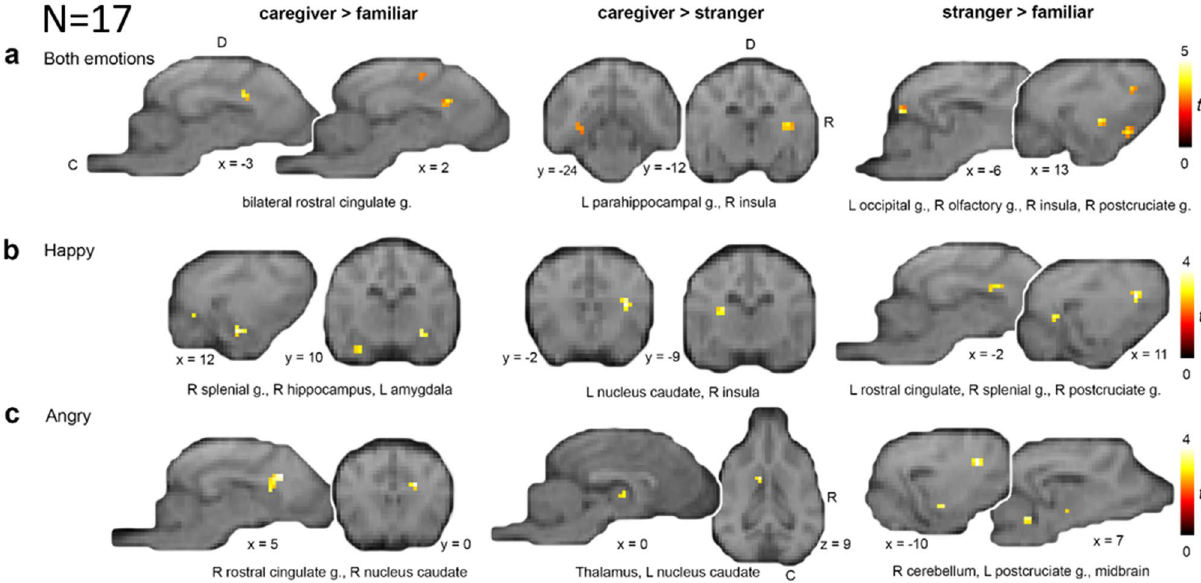
Figure 1. Visual presentation of caregiver (compared to the familiar person or stranger; independent of emotional facial expression) elicited activation increases in areas associated with the attachment system in humans, whereas visual presentation of the stranger (compared to the familiar person) mainly recruited motor and visual processing regions. The caregiver revealed activation in caudate regions for both happy and angry emotional facial expressions. Results are displayed at p < 0.005 with a minimum cluster size of 5 voxels (see Table 2 for details), projected onto the mean structural image derived from all dogs. Coordinates refer to the canine breed-averaged atlas 65 . The first sagittal and coronal planes ( a , first row) and transverse plane ( c , last row) show the anatomical locations caudal (C), dorsal (D), and right hemisphere (R); all sagittal and coronal planes displayed have the same orientation. Group-based comparison of caregiver against familiar